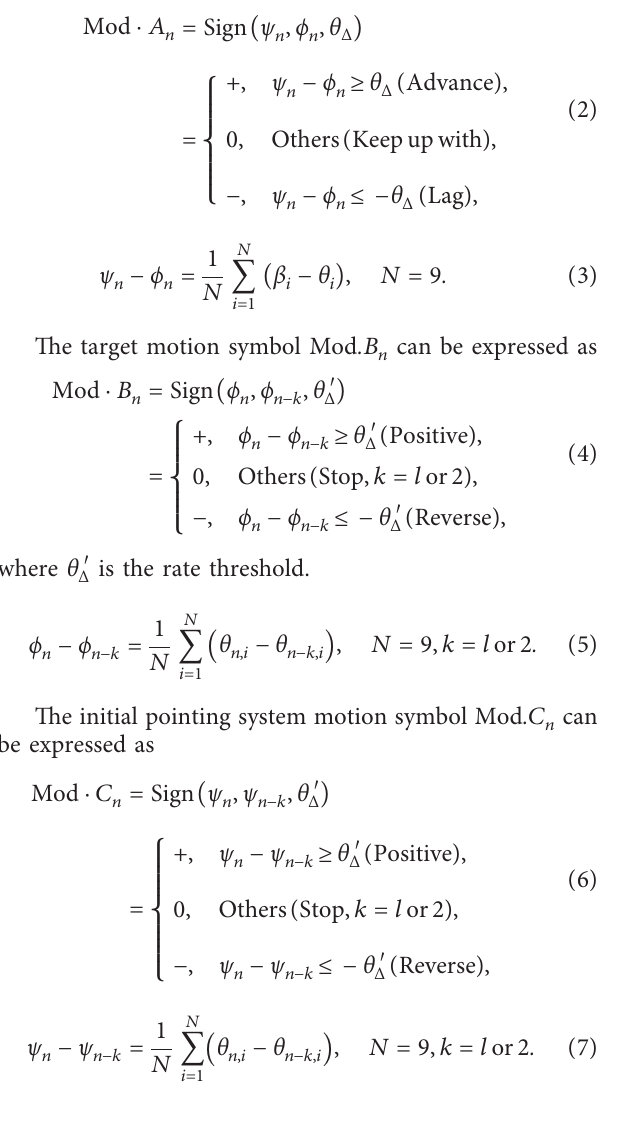
Figure 13: Damping performance of inertial stability platform.